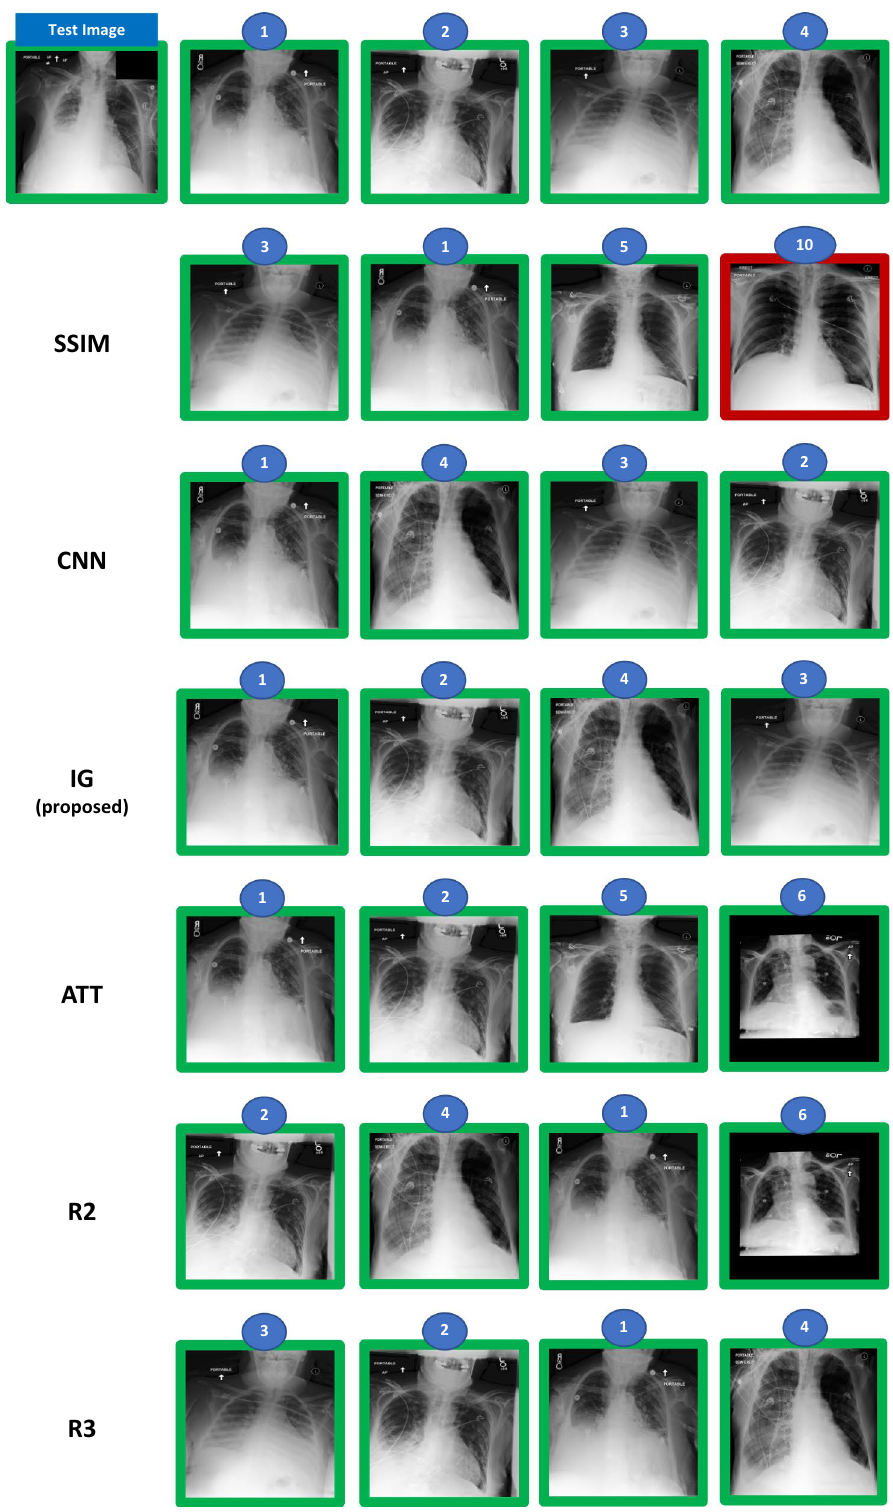
Figure 6. Example of test case and the Top-4 retrieved images given by each of the radiologists (R1 = ground- truth, R2, and R3) and each of the machine learning methods. In this split, both the CNN, IG, and ATT obtained nDCGs (Top-10) > 0.9. The green box means pleural effusion case and the red box means no pleural effusion (according to the dataset